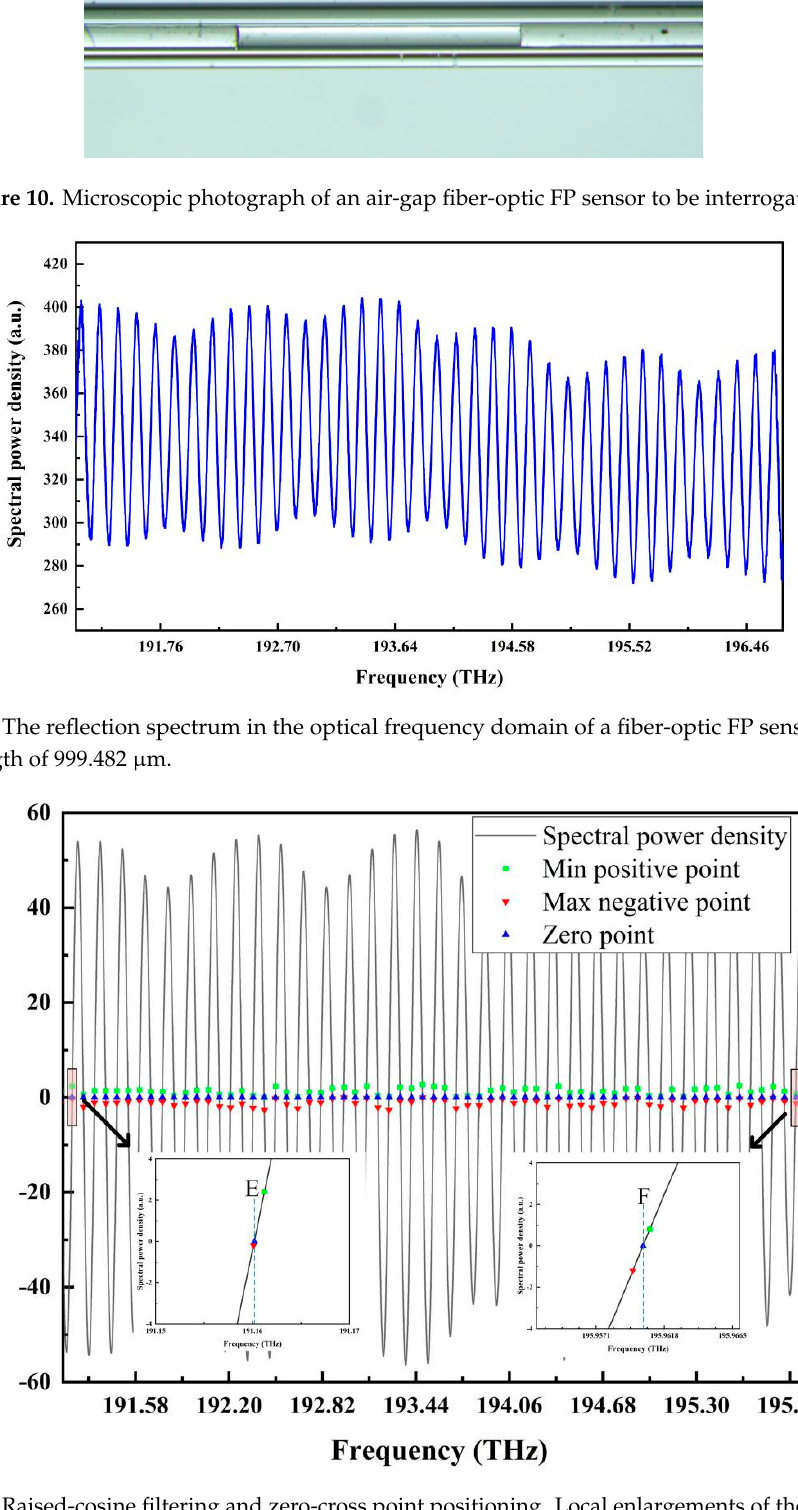
Figure 12. Raised-cosine filtering and zero-cross point positioning. Local enlargements of the first and last zero points in ascending segments are also given, in which the two zero points are marked by E and F.